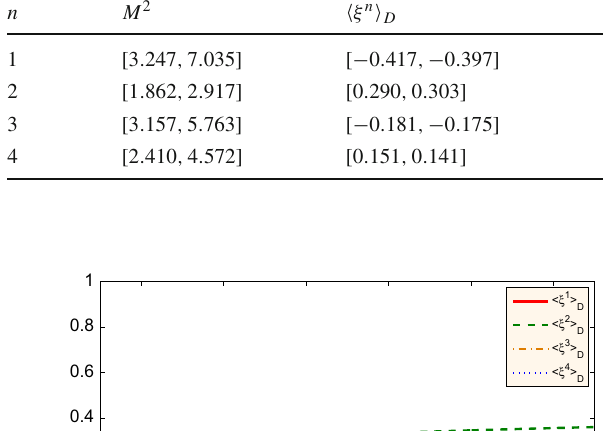
(cid:3) (cid:3) (cid:3) (cid:3) (cid:2) (cid:2) (cid:2) (cid:2) ξ 1 ξ 2 ξ 3 ξ 4 , , and , respectively D D D D